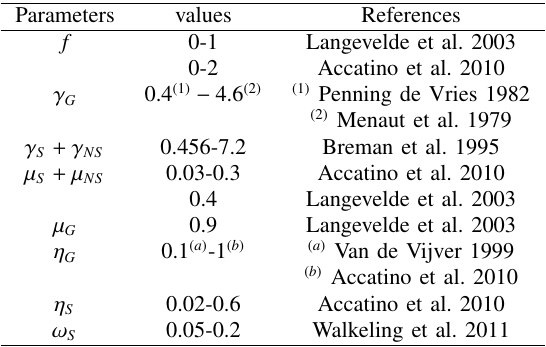
P arameters values found in literature